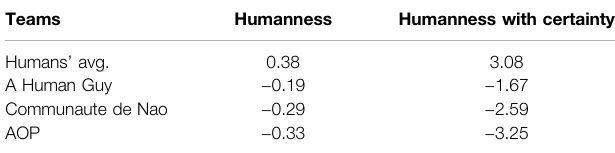
TABLE 2 | Competition results.